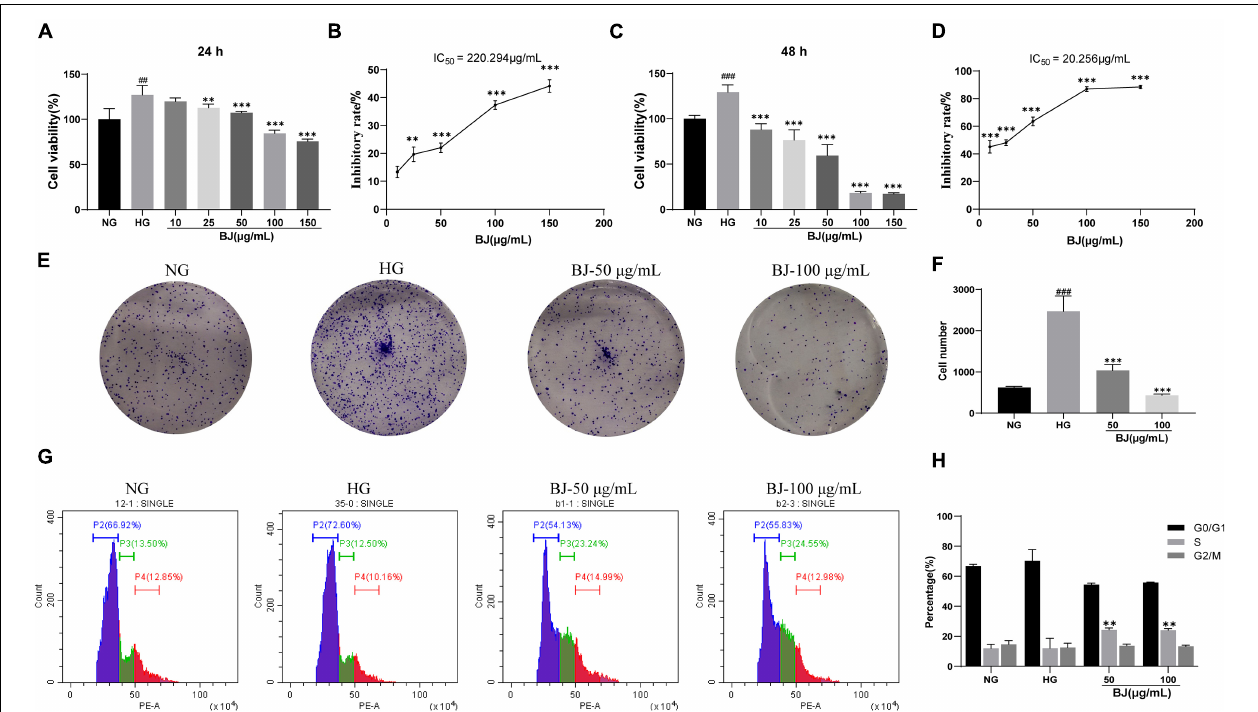
FIGURE 4 | Bie-Jia-Ruan-Mai-Tang (BJ) represses the viability and proliferation of high-glucose-exposed HRCECs. After treatment with BJ for 24 h (A) and 48 h (C) , respectively, the CCK-8 kit was used to detect the cell viability of HRCECs ( n = 6). The corresponding IC 50 values were calculated according to the results of the cell counting assay, which were 220.294 µ g/mL (B) and 20.256 µ g/mL (D) , respectively. Cell colony formation assay (E,F) was performed to detect the proliferation of cells ( n = 3). Cell cycle analysis (G,H) indicated that high-glucose-exposed HRCECs were arrested at the S phase by BJ ( n = 3). HRCECs cultured with normal-glucose (NG) were used as control. All data are expressed as mean ± SD. ## P < 0.01, ### P < 0.001 vs. NG; ∗∗ P < 0.01, ∗∗∗ P < 0.001 vs.